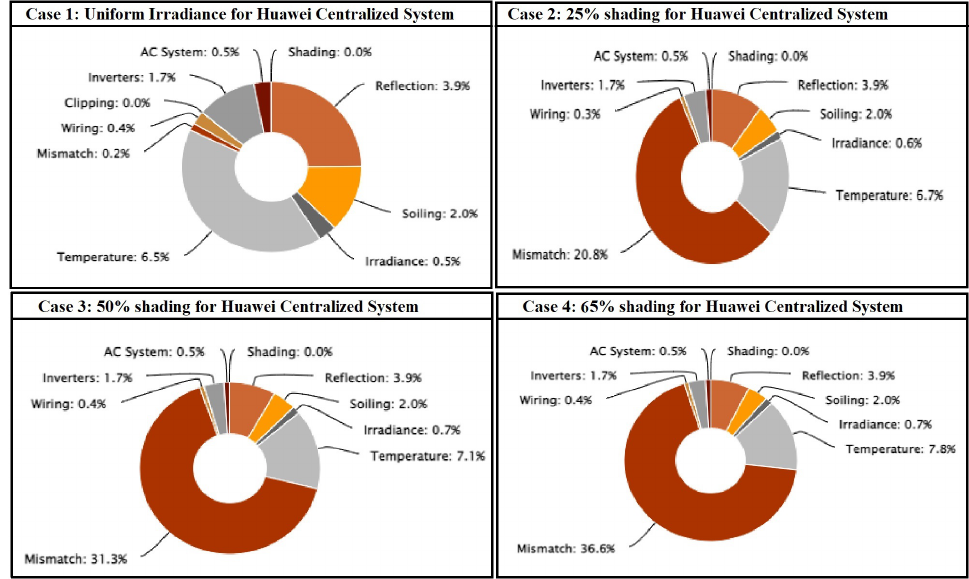
Figure 43. Results of various losses of Huawei centralized system on different shading conditions using Helioscope.